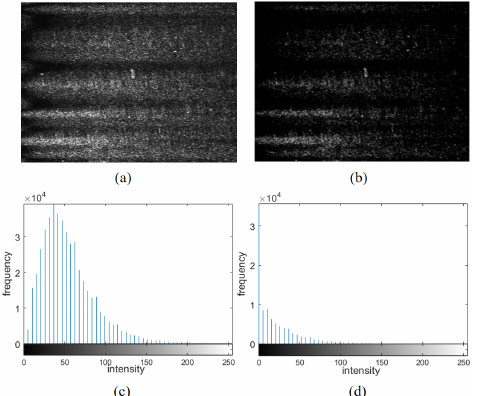
Figure 3. Original SSS image and preprocessed image. ( a ) A representative SSS image. ( b ) The preprocessed image. ( c ) The histogram of the original SSS image ( a ). ( d ) The histogram of the preprocessed image ( b